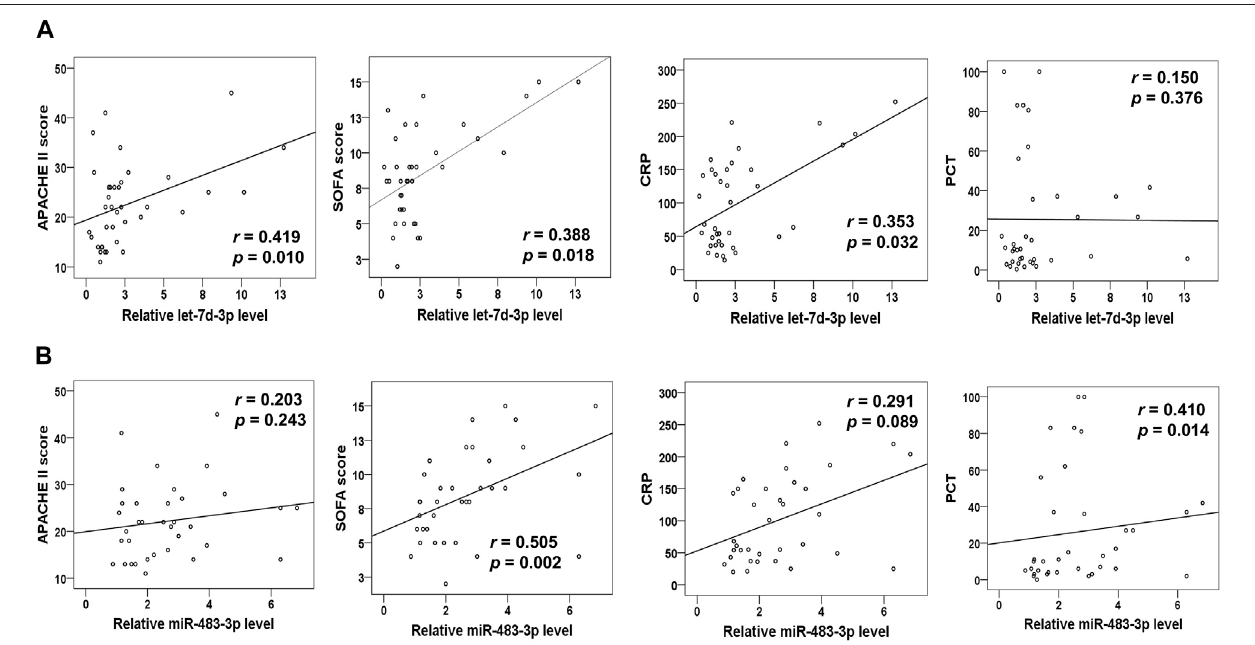
FIGURE4| Correlation analysisofplasmaEVmiRNAlevels (miR-483-3pandlet-7d-3p)withdisease severityscoresand biomarkersforsepsis. (A) Thecurve was plotted by let-7d-3p relative expression values at admission of sepsis patients to their individual APACHE II and SOFA scores as well as CRP and PCT values. (B) The curve was plotted by miR-483-3p relative expression values at admission of sepsis patients to their individual APACHE II and SOFA scores as well as CRP and PCT levels. Each circle represents an individual patient. n = 35 – 37.